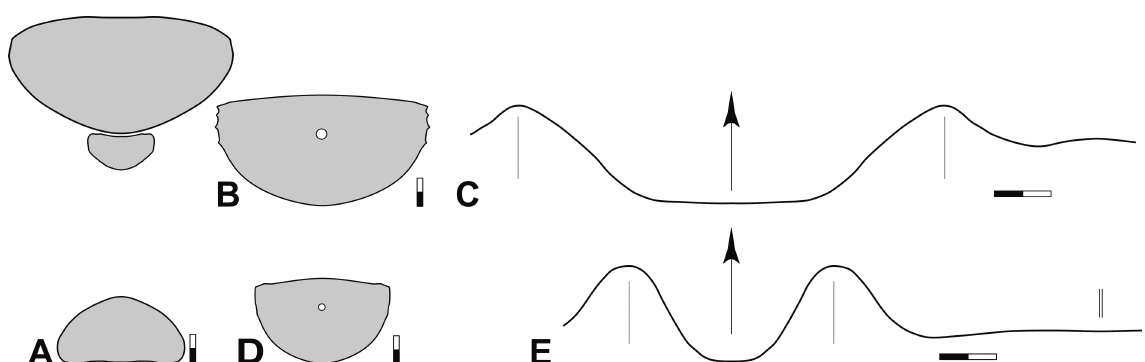
Fig. 19. Vestinautilus inflexus sp. nov. from Oued Temertasset (both Korn et al . 2002 Coll.). A . Cross section of paratype MB.C.30472.2. B . Whorl profile of holotype MB.C.30472.1. C . Suture line of holotype MB.C.30472.1, at ww = 15.2 mm, wh = 7.2 mm. D . Whorl profile of paratype MB.C.30472.3. E . Suture line of paratype MB.C.30472.3, ww = 8.7 mm, wh = 5.8 mm. Scale bar units = 1